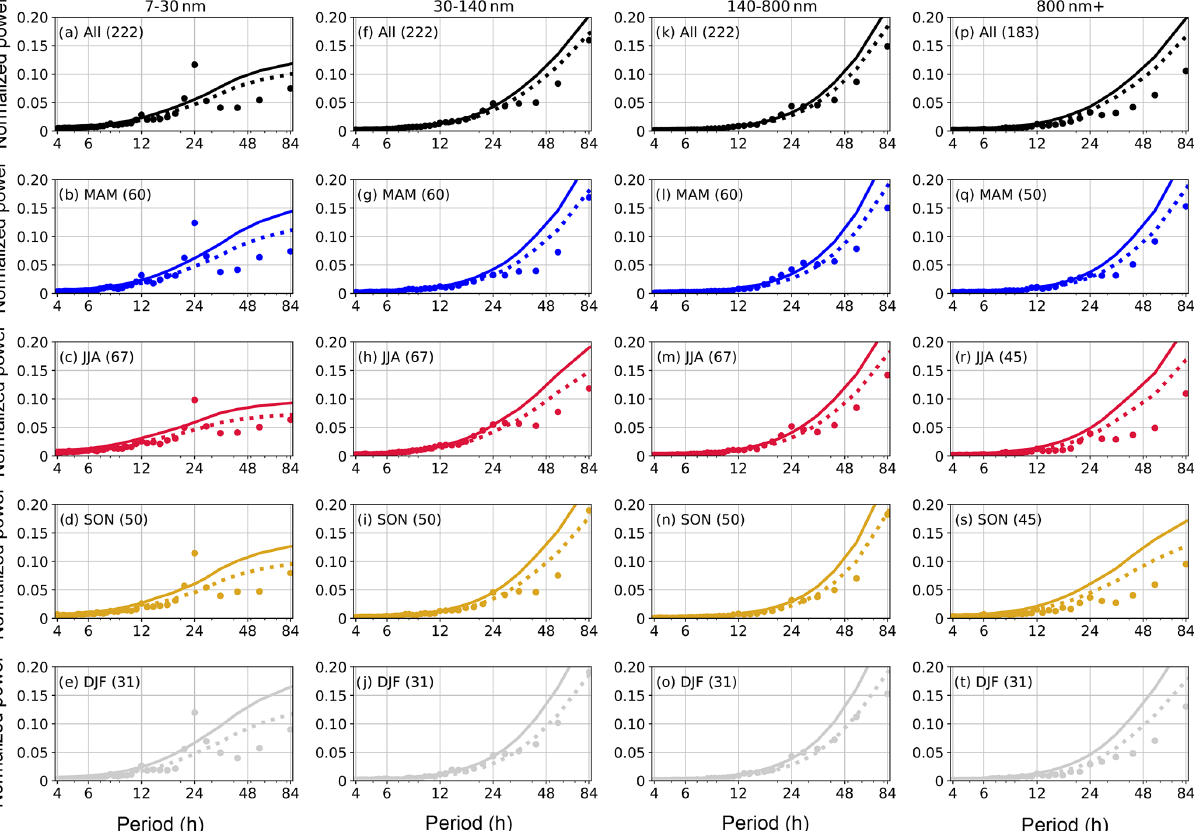
Figure 7. Normalized power spectra for N 7 − 30nm , N 30 − 140nm , N 140 − 800nm , and N 800nm + for the entire period and by season. The descriptions of the symbols used are the same as in Fig.